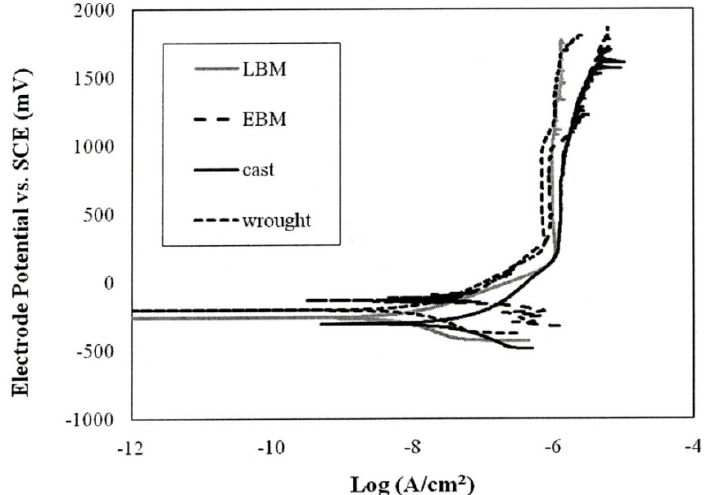
Figure 16. Typical anodic polarization behavior of Ti-6Al-4V ELI specimens using different fabrication